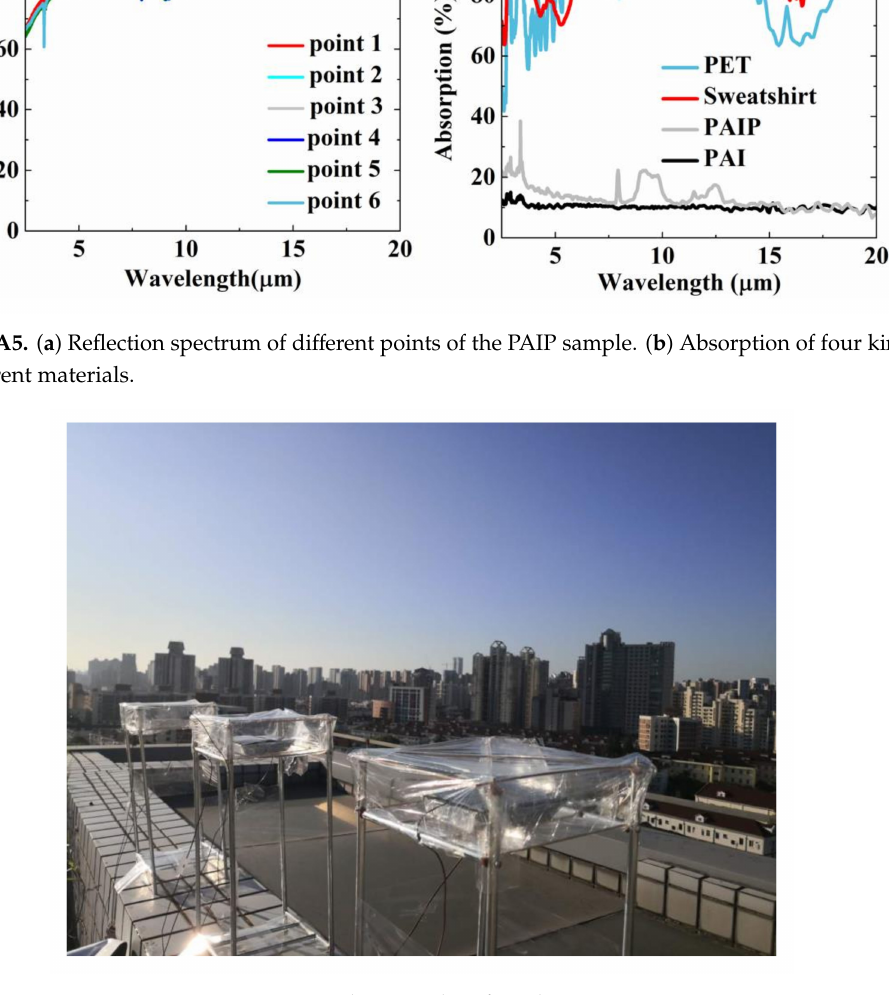
Figure A6. Photography of outdoor